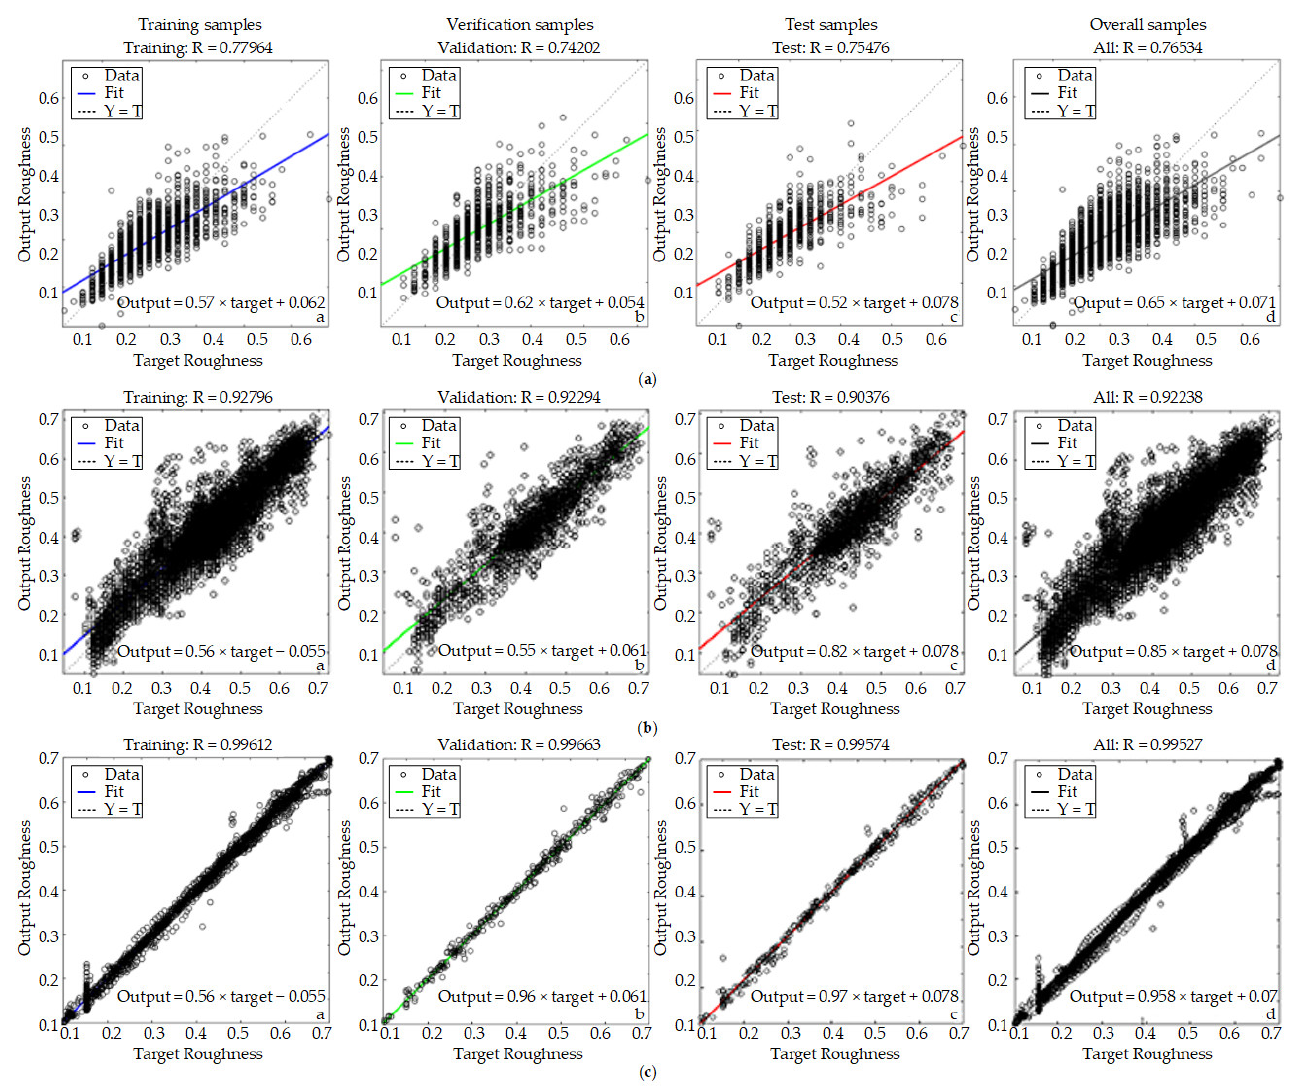
Figure 10. Model fitting diagram: ( a ) BP model; ( b ) SOM-RBF model; ( c ) RLSOM-RBF model.